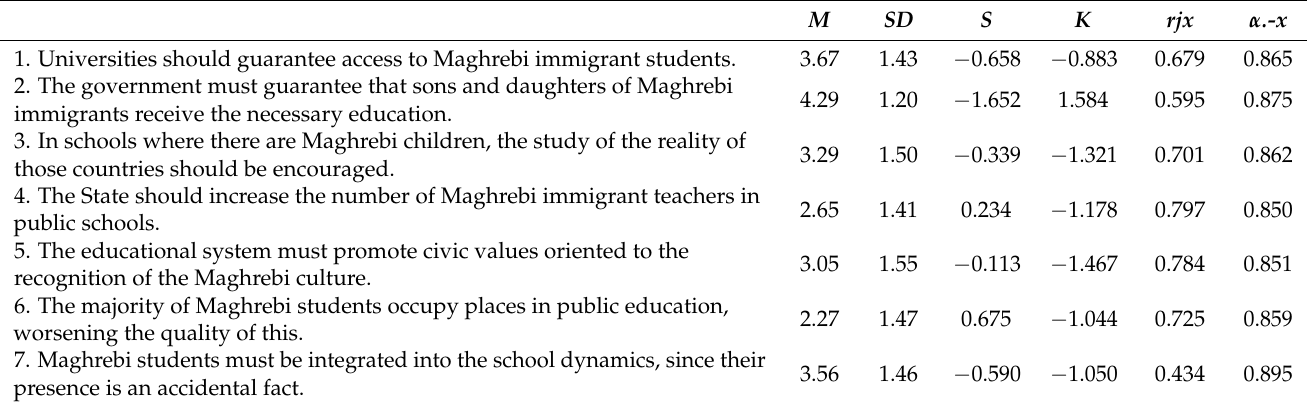
Table 1. Items of Attitudes toward Maghrebis in Education Scale